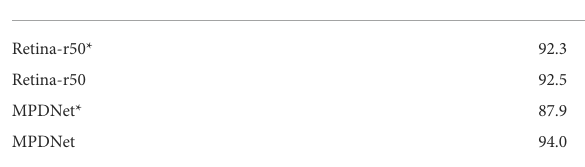
TABLE 4 Experimental results of